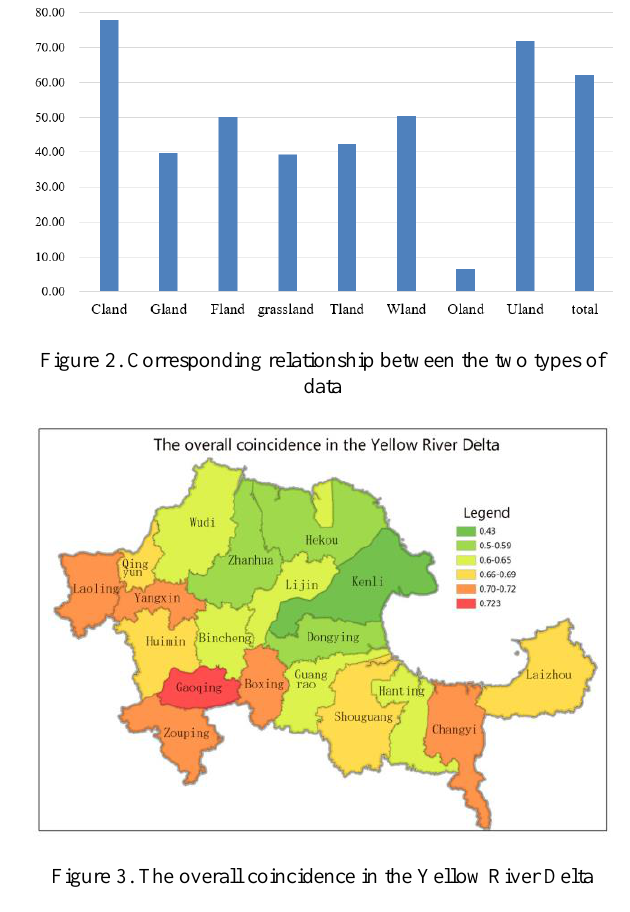
Figure 3. The overall coincidence in the Yellow River